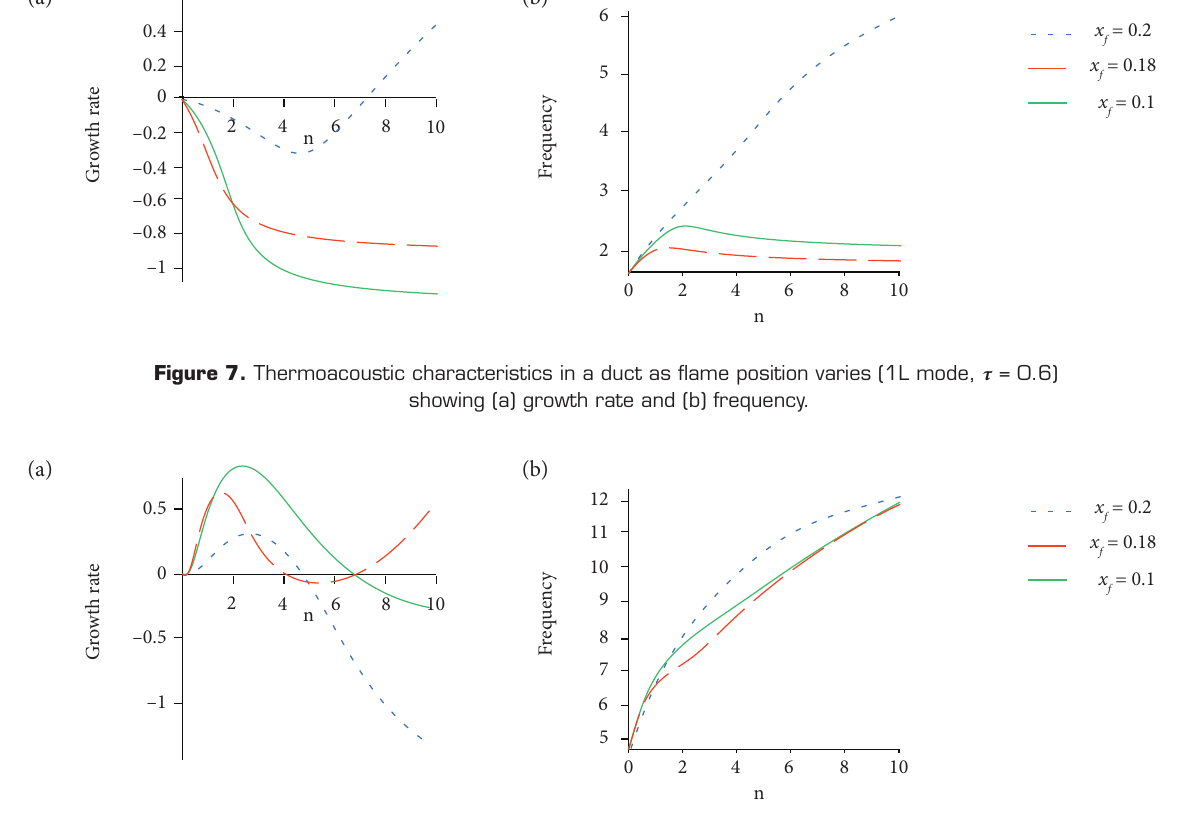
Figure 8. Thermoacoustic characteristics of a duct as flame position varies (3L mode, τ = 0.6) showing (a) growth rate and (b) frequency.